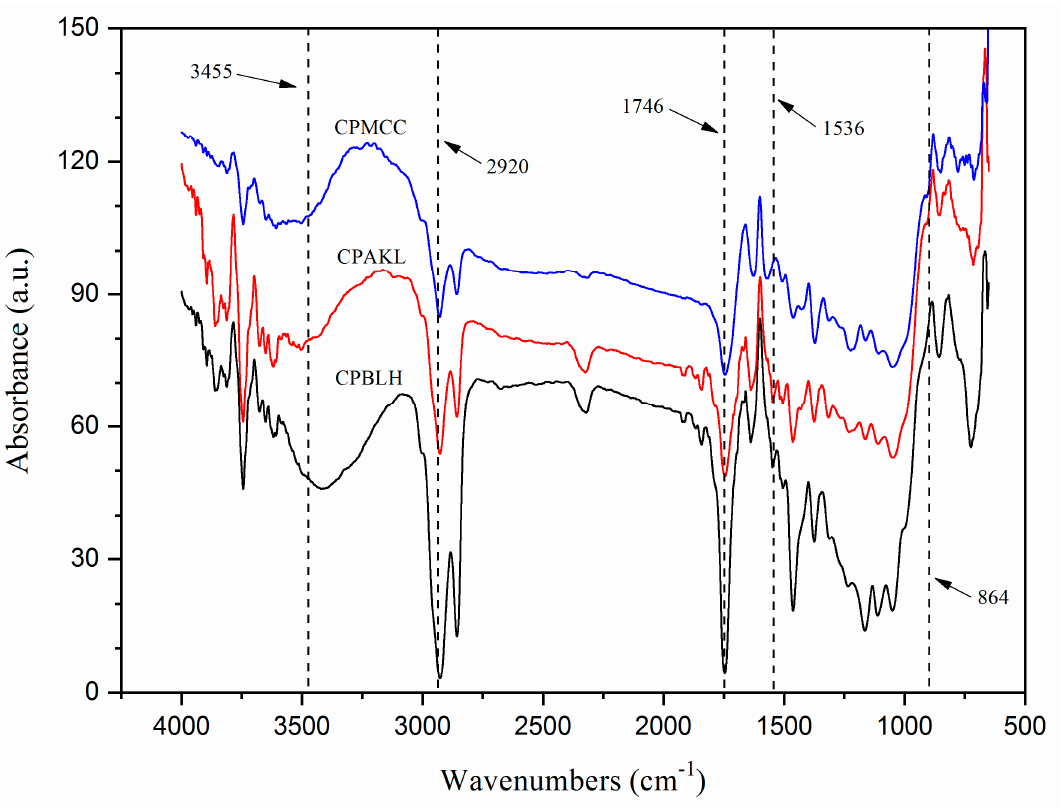
Polymers 2020 , 12 , x FOR PEER REVIEW Figure 3. FTIR spectra of CPBLH, CPAKL, and CPMCC samples. Figure 3. FTIR spectra of CPBLH, CPAKL, and CPMCC samples.